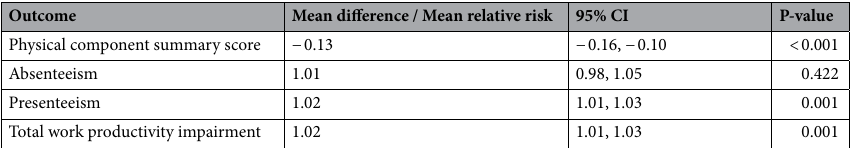
Table 6. Effect of one more ophthalmologist visit in the past six months on PCS score and work productivity loss, after adjusting for age, gender, CCI, and smoking status, respectively. CCI Charlson comorbidity index, CI confidence